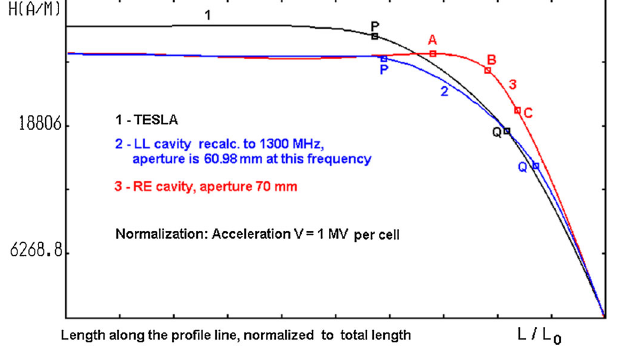
FIG. 5. Magnetic field on the surface of the cavities from Fig.